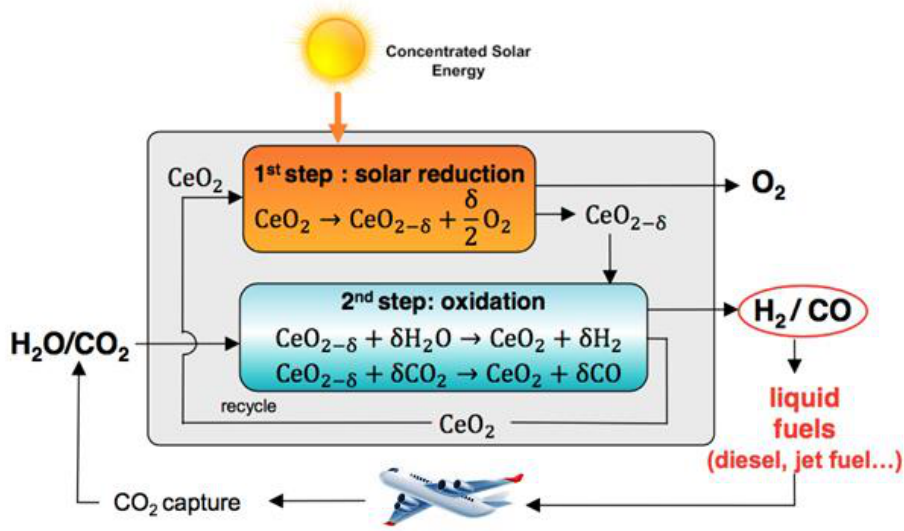
Figure 2. The two-step thermochemical redox process for the splitting of CO 2 using ceria [21].